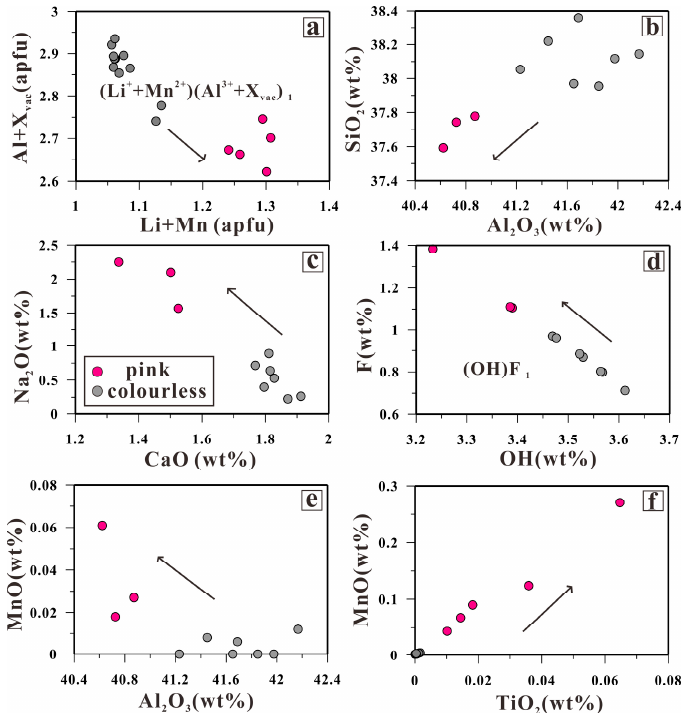
Figure 5. Major elements of tourmaline: ( a ) Li+Mn vs. Al+X vac ; ( b ) Al 2 O 3 vs. SiO 2 ; ( c ) CaO vs. Na 2 O; ( d ) OH vs. F; (e) Al 2 O 3 vs. MnO; (f) TiO 2 vs. MnO.